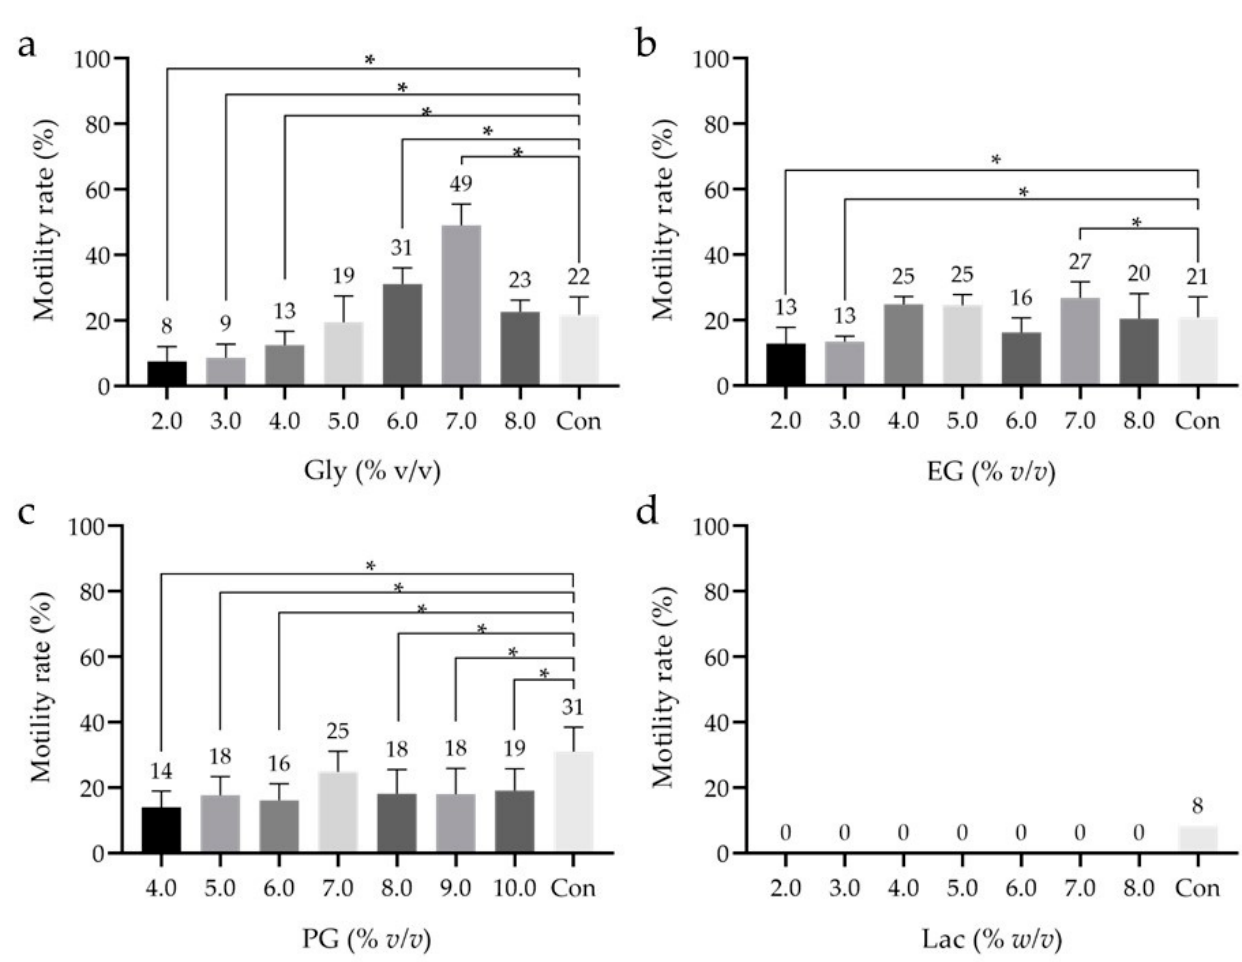
Figure 2. Sperm motility rate after freeze–thawing with cryopreservation reagents containing low-Mw cryoprotective agents (CPAs) at different concentrations. ( a ) Glycerol (Glyc). ( b ) Ethylene glycol (EG). ( c ) Propylene glycol (PG). ( d ) Lactamide (Lac). The motility of sperms with Lac could not be confirmed under all conditions. Thus, the measurement of Lac was performed only once. CPLL at 5% w / v was used as the macro-Mw CPA, and no additional saccharides were used. Dunnett’s test was performed to compare sperm motility rates after freeze–thawing with that of the control; p -value < 0.05 was considered statistically significant. The data are expressed as the means ± standard deviations ( a – c ; n = 9, d; n = 1). Asterisks (*) indicate a statistically significant difference; low-Mw CPA, low-molecular-weight cryoprotective agent; macro-Mw CPA, macromolecular-weight cryoprotective agent; Con, commercial cryopreservation reagent (Fujifilm Ir- vine).